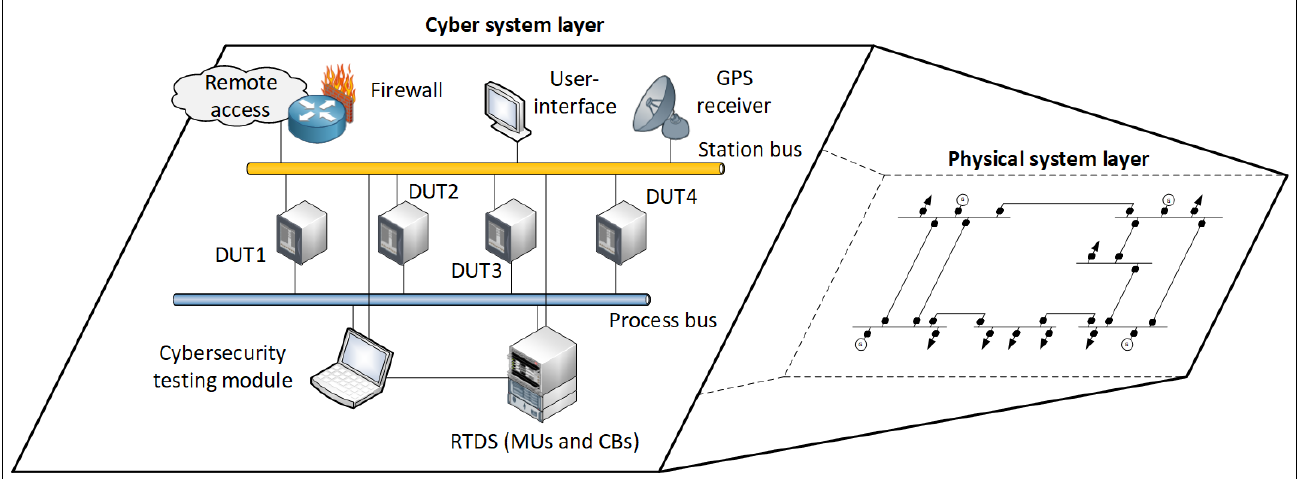
Figure 5. Hardware-in-the-loop (HIL) test bed for cybersecurity